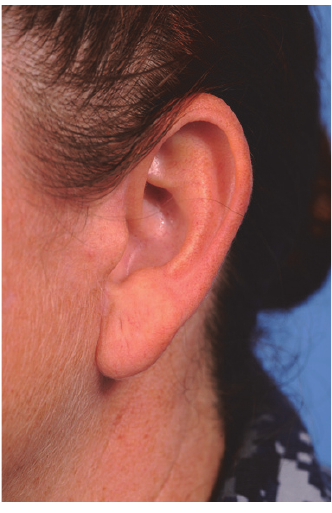
Figure 2: Intraoperative photograph showing conchal cartilage harvest through a postauricular incision.